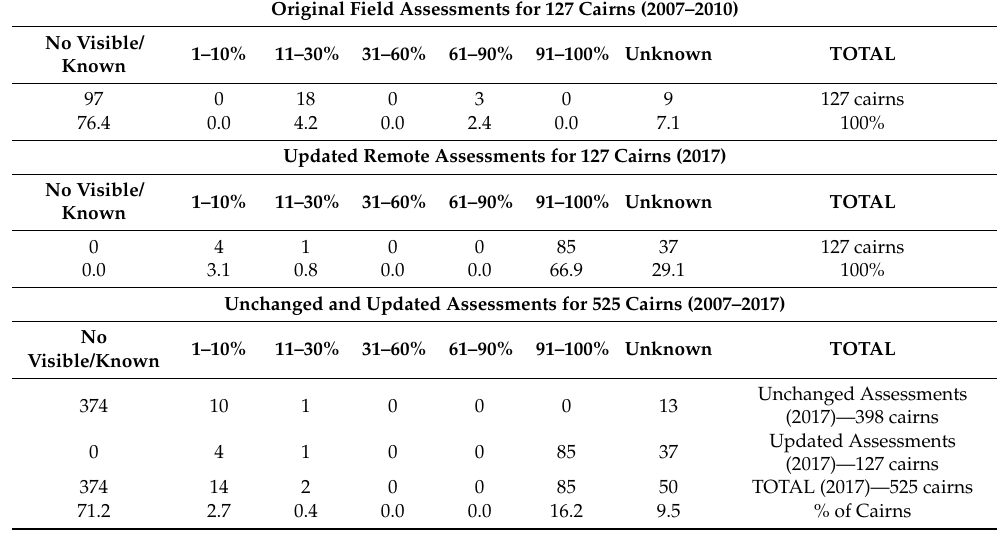
Table 9. Disturbance Extent (%) based on field survey and remote assessment. The category ‘No Visible/Known’ includes sites where it was possible to make a disturbance assessment, but no disturbances were visible. ‘Unknown’ indicates sites were it was not possible to make a disturbance assessment due to lack of data, cloud cover and/or poor imagery resolution.